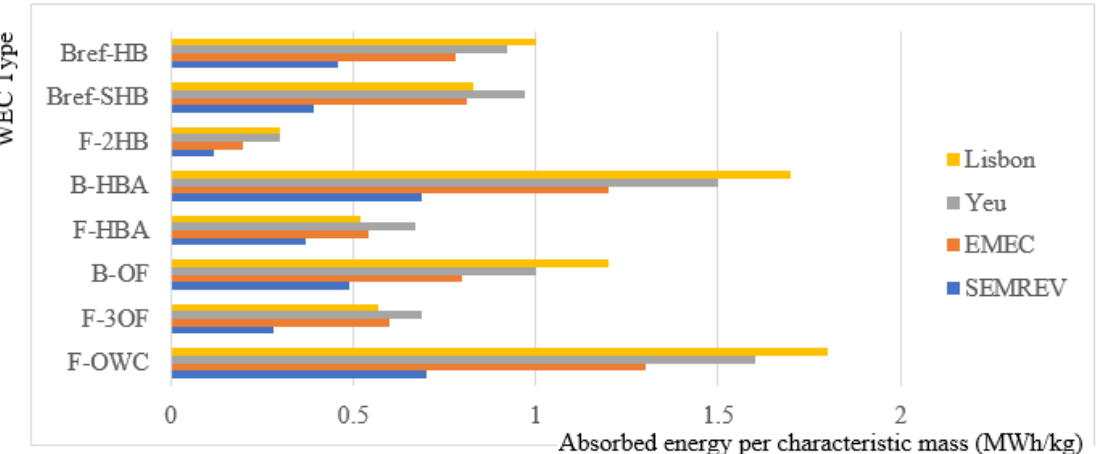
Figure 2. Performance comparison of the absorbed energy per characteristic mass of WECs.